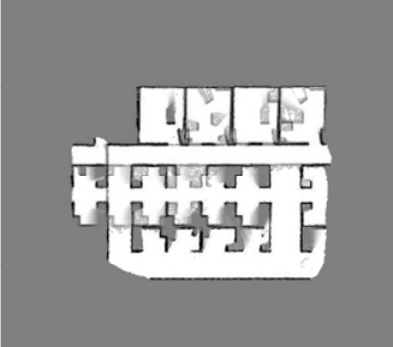
Fig. 5. The failed merging of map 1 and map 3 (best hypothesis acceptance indicator 0.828)